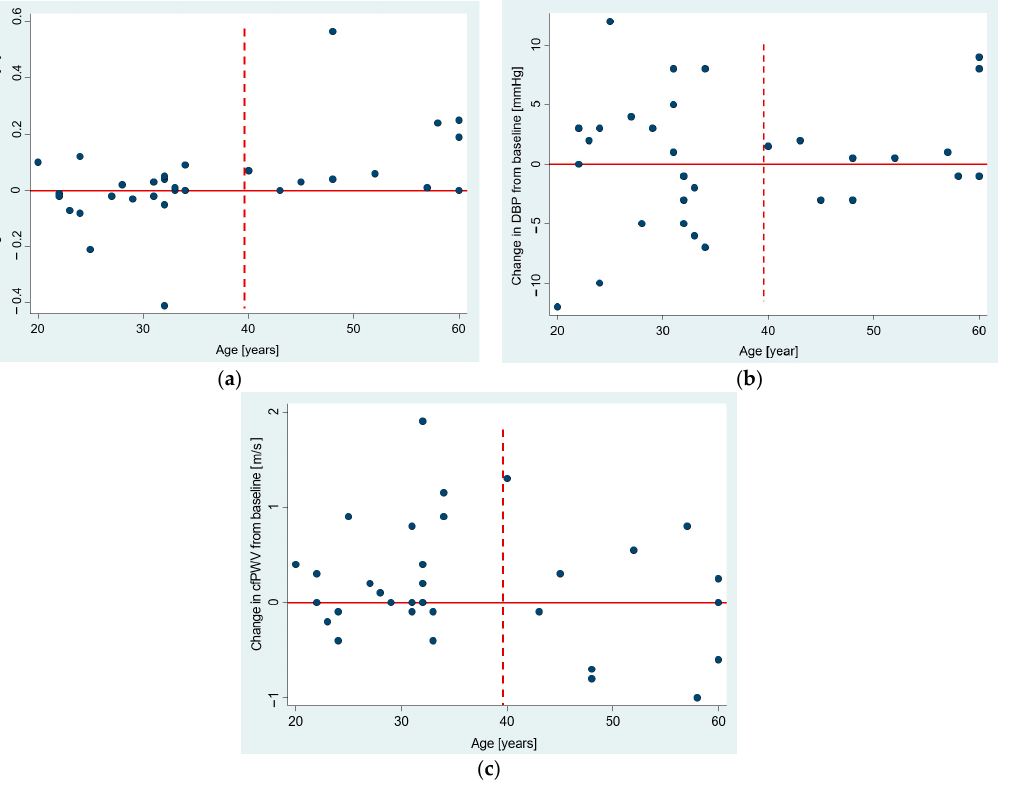
Figure 3. Scatter plots showing the relationship between age and pre–post change in: ( a ) augmenta- tion index AIx P2/P1, ( b ) diastolic blood pressure, and ( c ) cfPWV. The horizontal reference line set at zero pre–post change, and the vertical dashed line set at 40 years that separates parts of a plot with apparently different dispersion patterns.